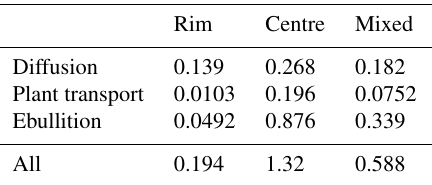
Table 1. Maximal values of the cumulative sums of modelled methane flux over the modelled time period for rim, centre and a mixed approach of 65% rim plus 35% centre for the different trans- port processes and combined in g Cm − 2 , rounded to three non-zero digits. Rim Centre